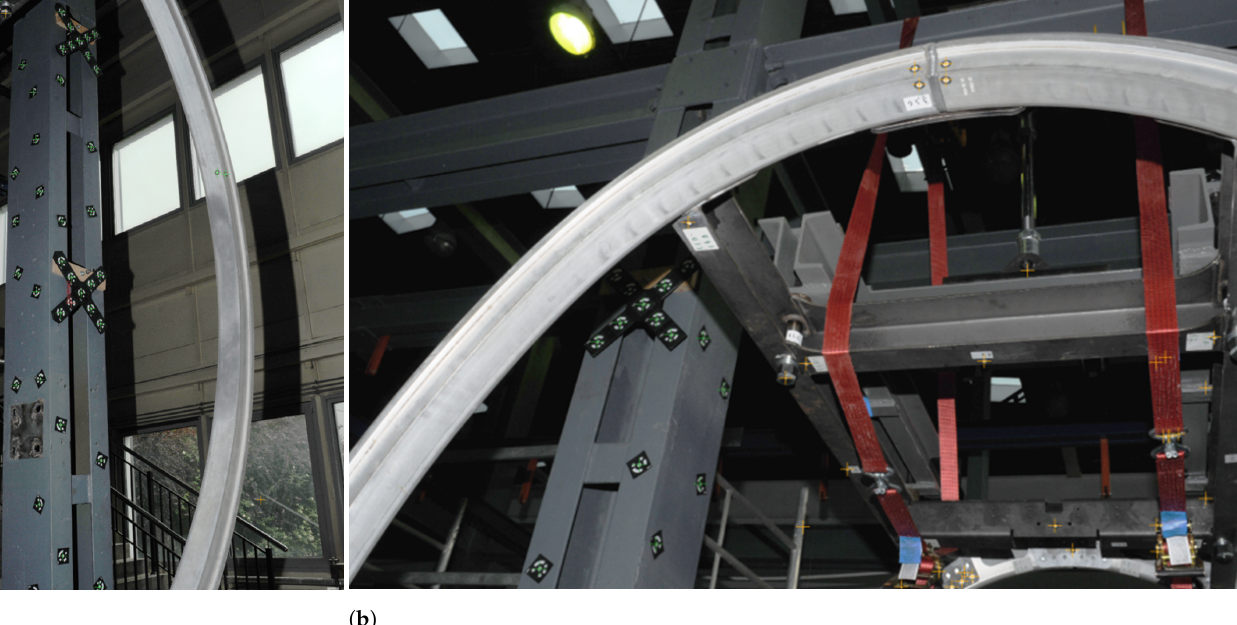
Figure 10. Location of coded reference points ( a ) and example of the arrangement of reference and measurement points ( b